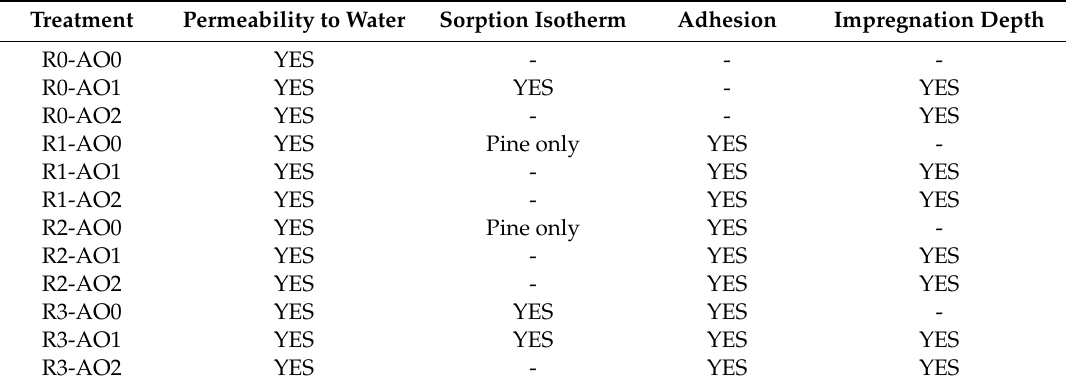
Table 4. Treatments that were used in each